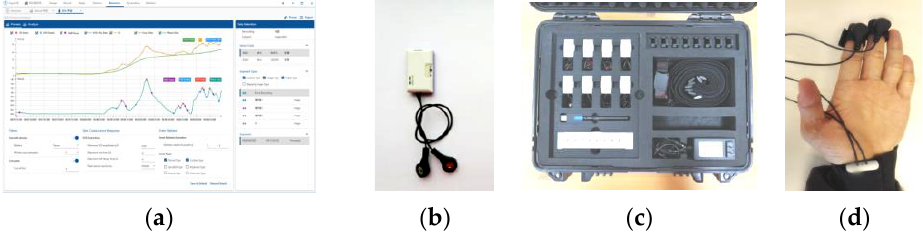
Figure 6. Instruments. ( a ) Human – machine environment synchronization experiment platform. ( b ) EDA modules. ( b ) EDA modules. ( c ) Physiological sensing kit. ( d ) Wearing instruments. ( b ) EDA modules. ( c ) Physiological sensing kit. ( d ) Wearing instruments.